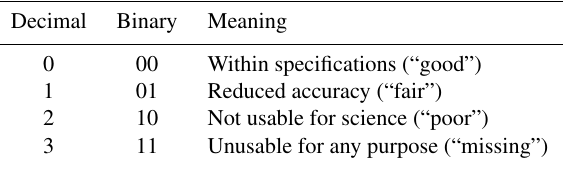
Table 1. Meaning of the 2-bit RDQI values in L1B2 GRP data